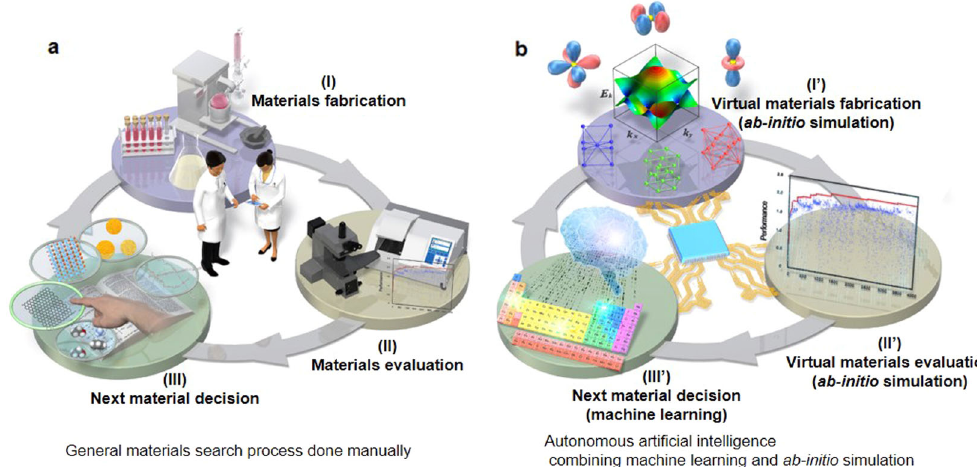
Fig. 1 Concept of autonomous materials search system. a Conventional materials search process done manually following a cycle comprising (I) a materials fabrication step, (II) a materials evaluation step, and (III) a decision step for selecting the next target material. b Autonomous materials search system in which the conventional process of materials search is simulated using computation technologies including ab-initio simulation and machine learning. The virtual materials fabrication step (I ′ ) and virtual materials evaluation step (II ′ ) are simulated using ab-initio simulation. The decision step for the next target material (II ′ ) is simulated using machine learning such as the game tree algorithm. This autonomous system automatically grows smarter as the amount of data acquired during the automated development cycle increases and eventually it fi nds a better